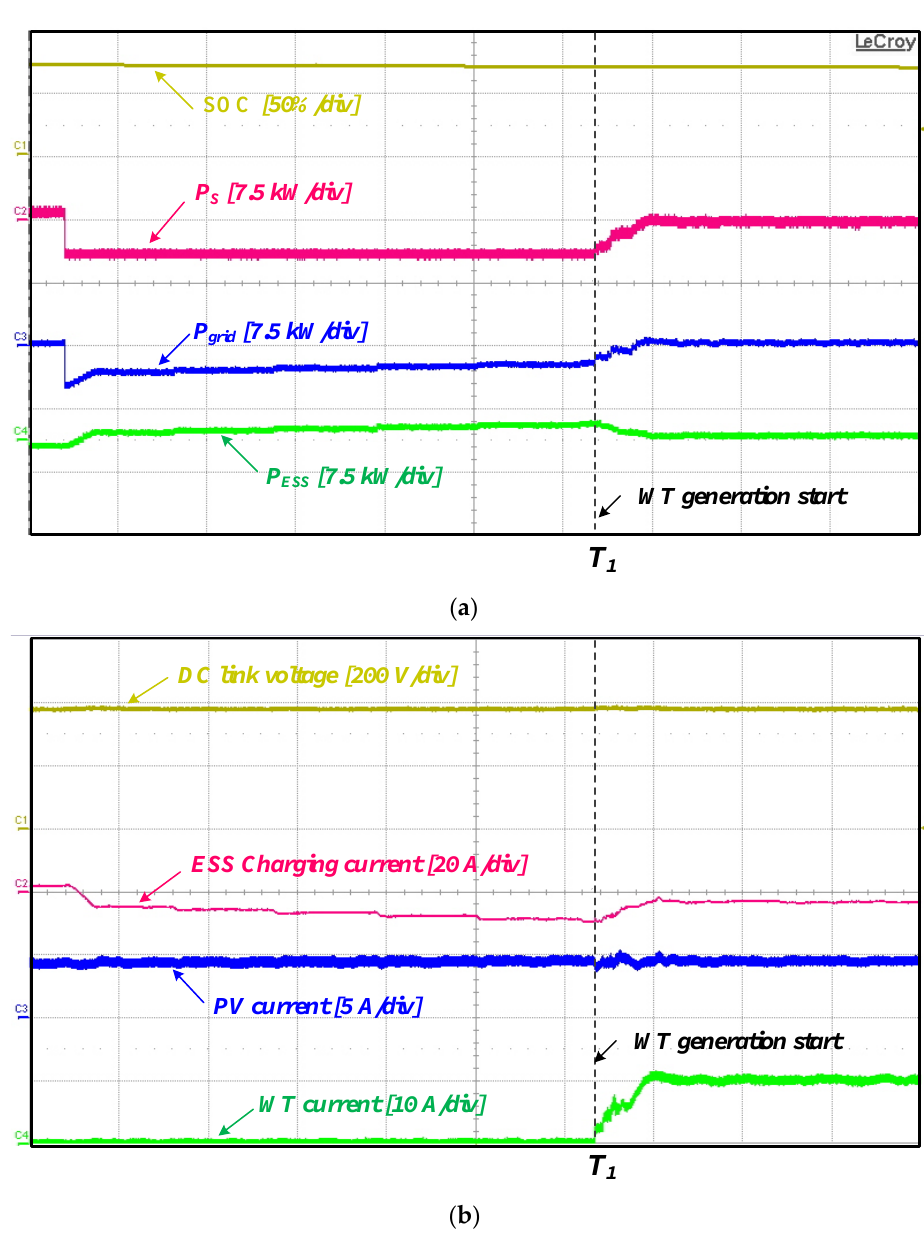
Figure 22. Experiment waveforms of operation mode 3 ( a ) ANN input/output data waveform, ( b )